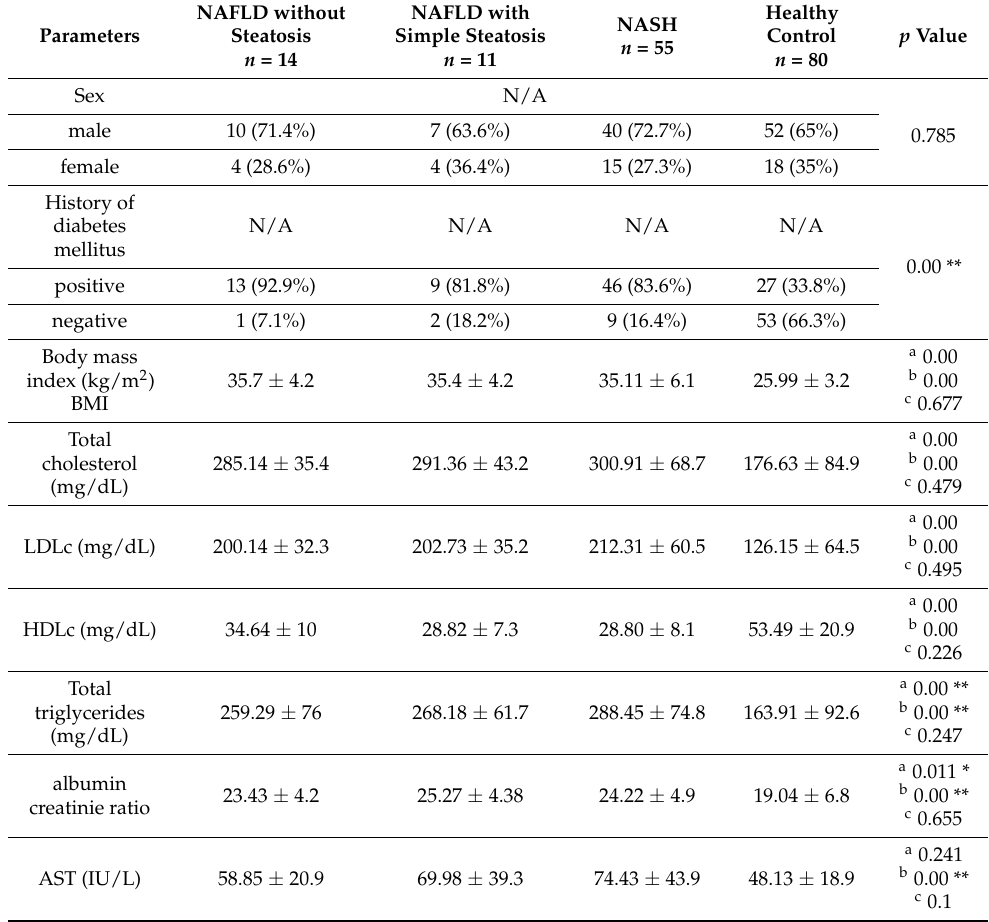
Table 1. Demographic and laboratory data in the study